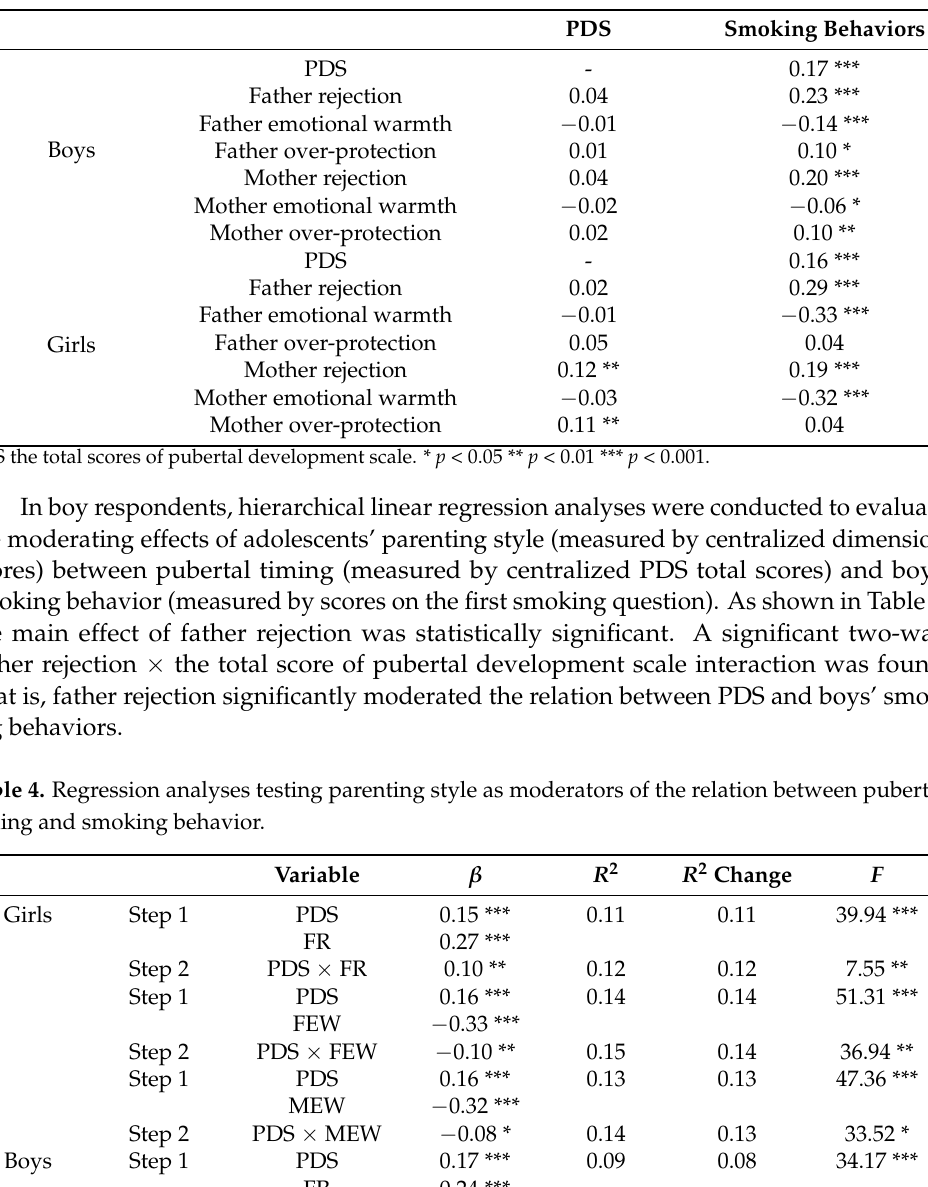
Table 3. Correlations among primary study variables.